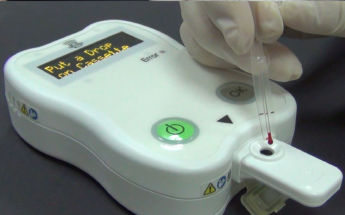
Figure 2. Physical photograph of the iProtin immunoassay and SH-SAW sensor chip coated with SARS-CoV-2 S